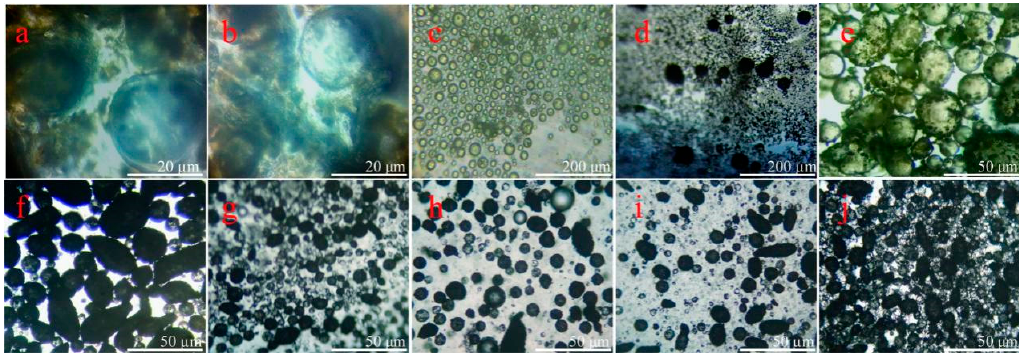
Figure 3. Optical microscope morphologies of core droplets in emulsion emulsified by hydrated SMA molecules, ( a ) core material dispersed into droplets by a stirring, ( b , c ) core droplets emulsified by SMA, ( d , e ) graphene and HMMA adsorbed on droplets, ( f ) microcapsules with graphene/HMMM shells; microcapsule samples in emulsion: ( g ) M-4, ( h ) M-5, ( i ) M-6, and ( j ) M-7.